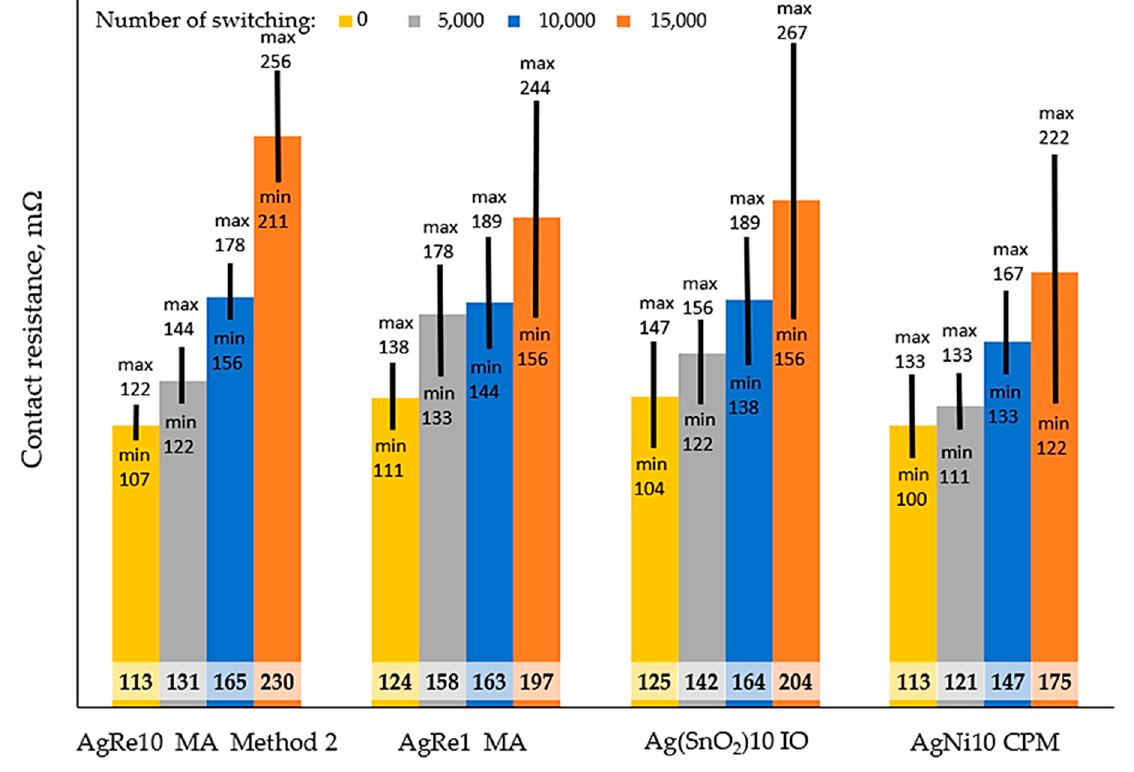
Figure 5. The results of the contact resistance tests, MA (mechanical alloying), IO (internal oxidation), CPM (classical powder metallurgy).